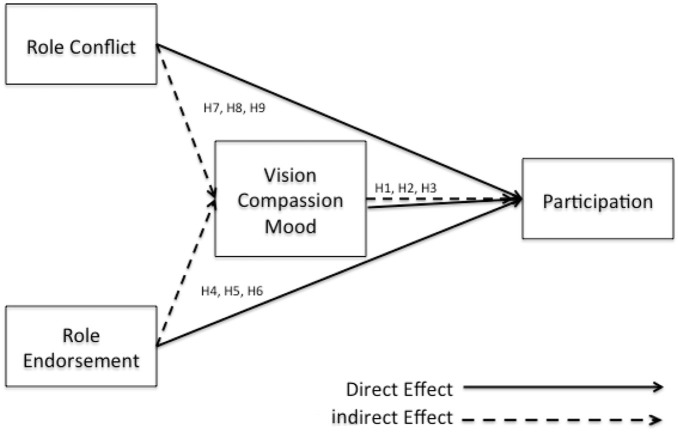
Conceptual model.